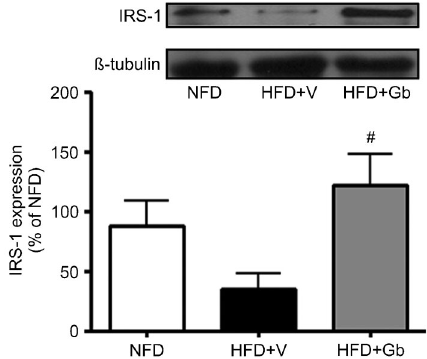
Figure 7. IRS-1 levels in gastrocnemius muscle of NFD (n=10), HFD++V (n=7), and HFD++Gb (n=9) groups after phytotherapy treatment. IRS-1: insulin receptor substrate 1; NFD: normal fat diet; HFD: high-fat diet; V: vehicle (saline); Gb: Ginkgo biloba . # P , 0.05 vs HFD++V (one-way ANOVA followed by the Tukey HSD